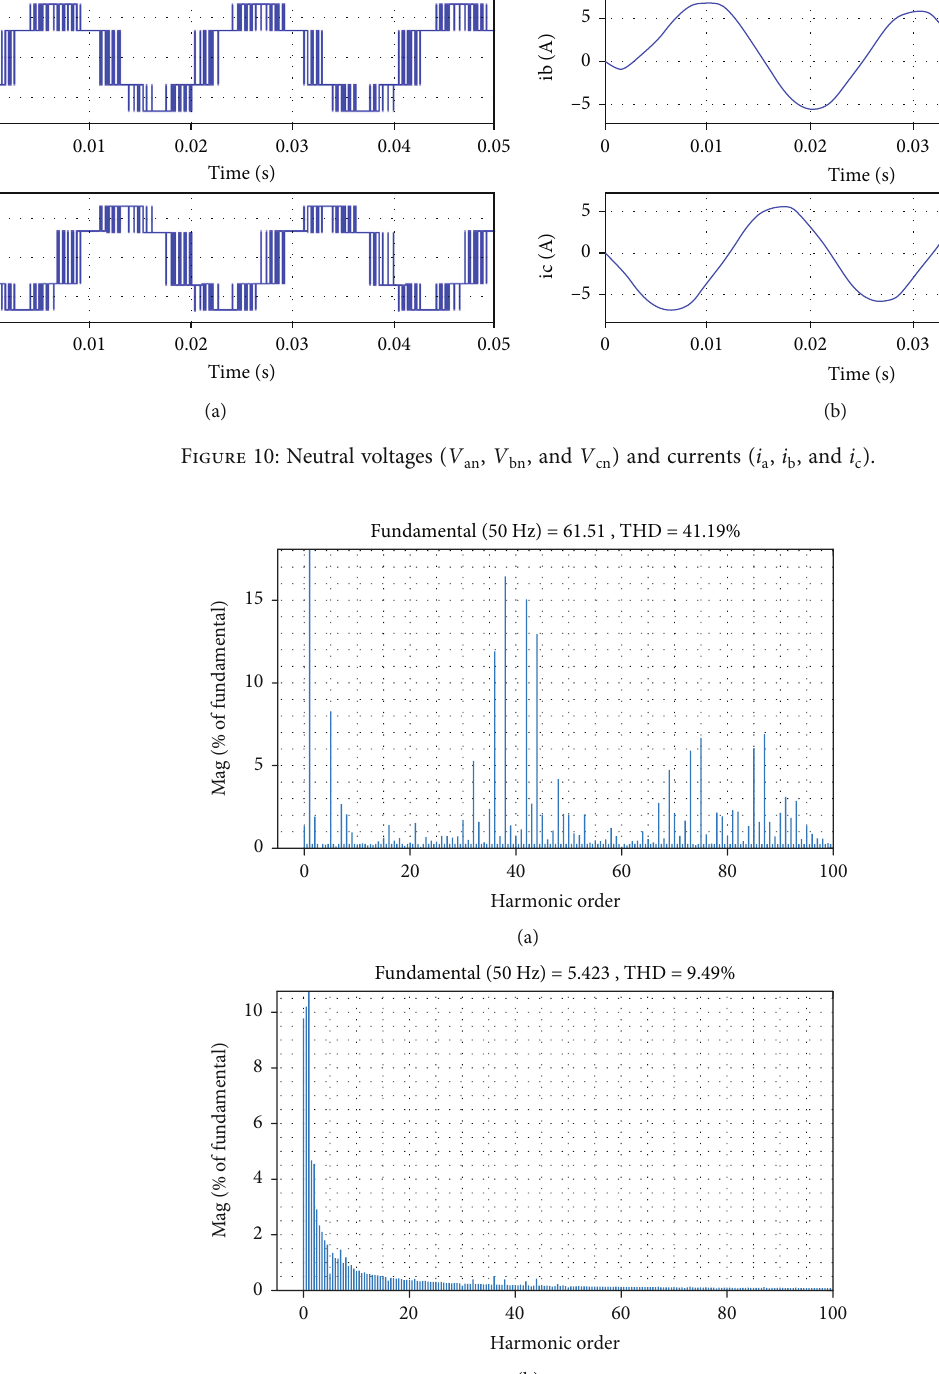
i i i a , b , and c